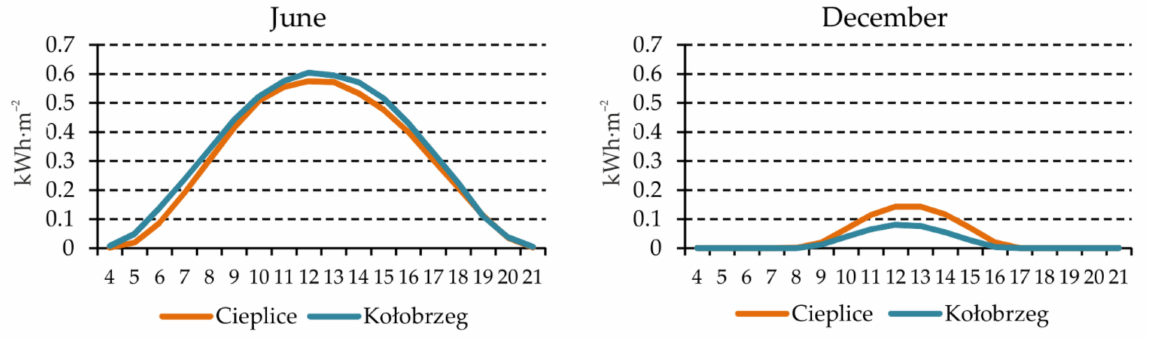
Figure 11. Daily course of hourly sums of global solar radiation in Cieplice and Kołobrzeg. Average values for December and June for the years